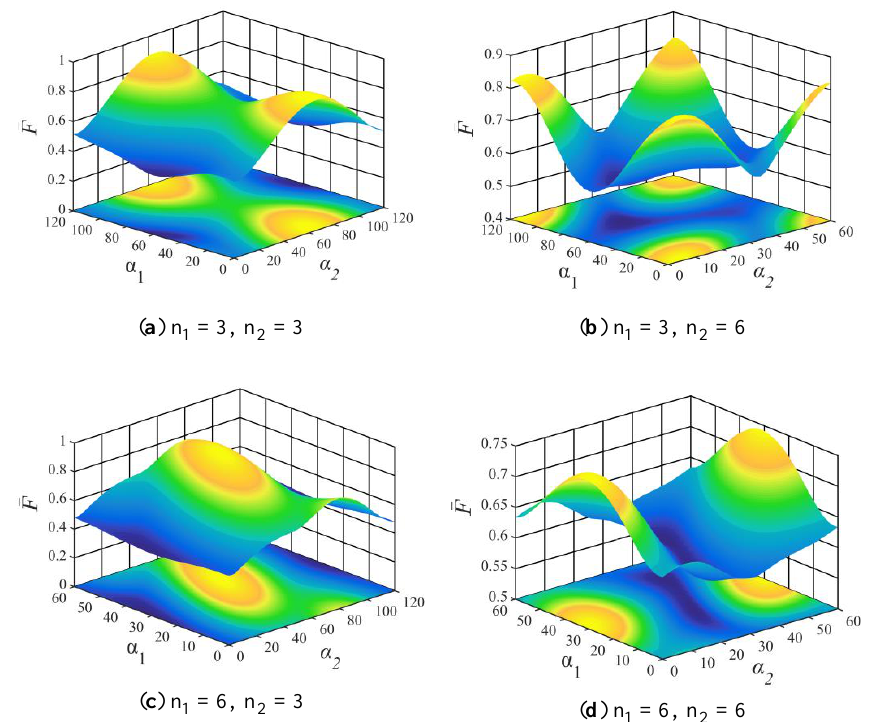
Figure 7. Variations of F with the waviness phase angle under four cases.